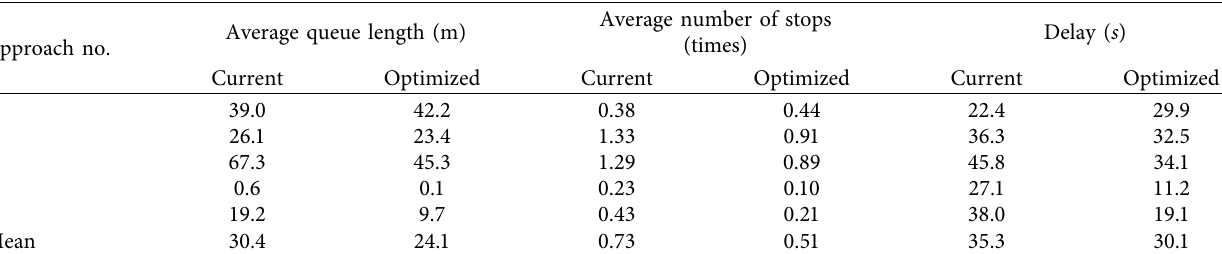
Table 8: Performance comparison results in cycle 1.